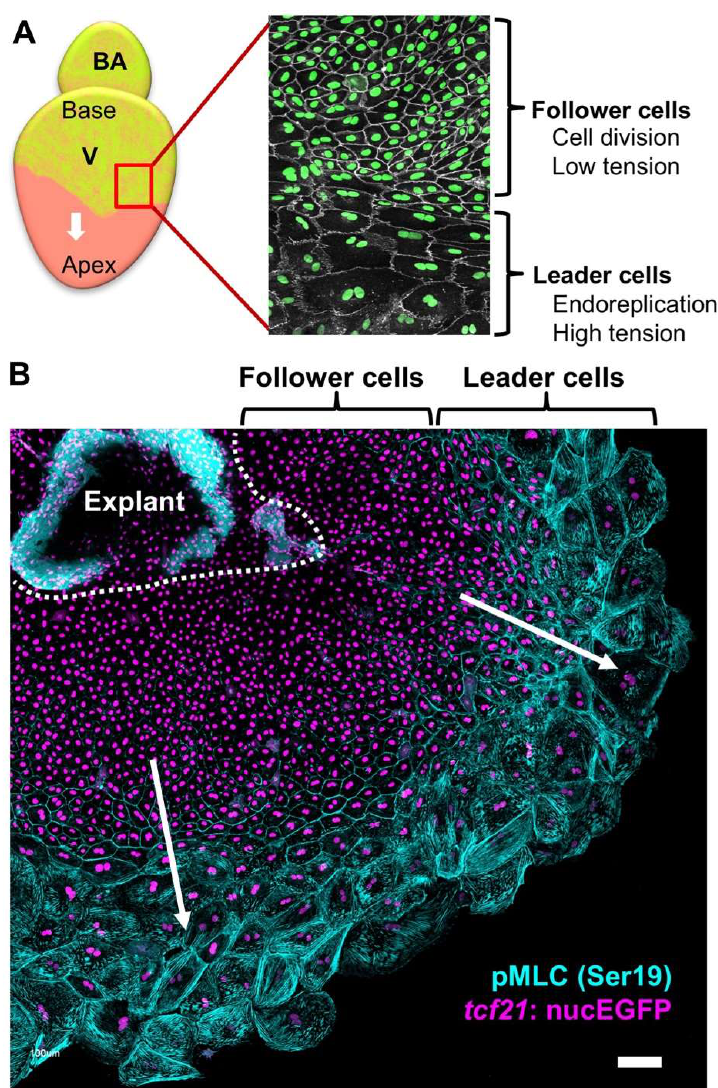
Figure 3. Two regions of the regenerating epicardial cell sheet. ( A ) Schematic of epicardial regeneration. The detail of the framed region of the regenerating epicardium is shown on the right. Nuclei are shown in green while cells are outlined in white. The epicardium forms two distinct domains: a leading edge of large, multinucleated leader cells followed by small, mononucleated follower cells. The follower cells have low cellular tension and undergo cell division, while the leader cells have high cellular tension and undergo endoreplication. ( B ) Migration of an epicardial cell sheet cultured in vitro showing two regions. Epicardial nuclei are labeled with tcf21: nucEGFP in violet. Immunostaining against phosphorylated myosin light chain 2 (pMLC, at Ser19, in cyan) was used as an indicator of mechanical tension. Scale bar: 100 μm.